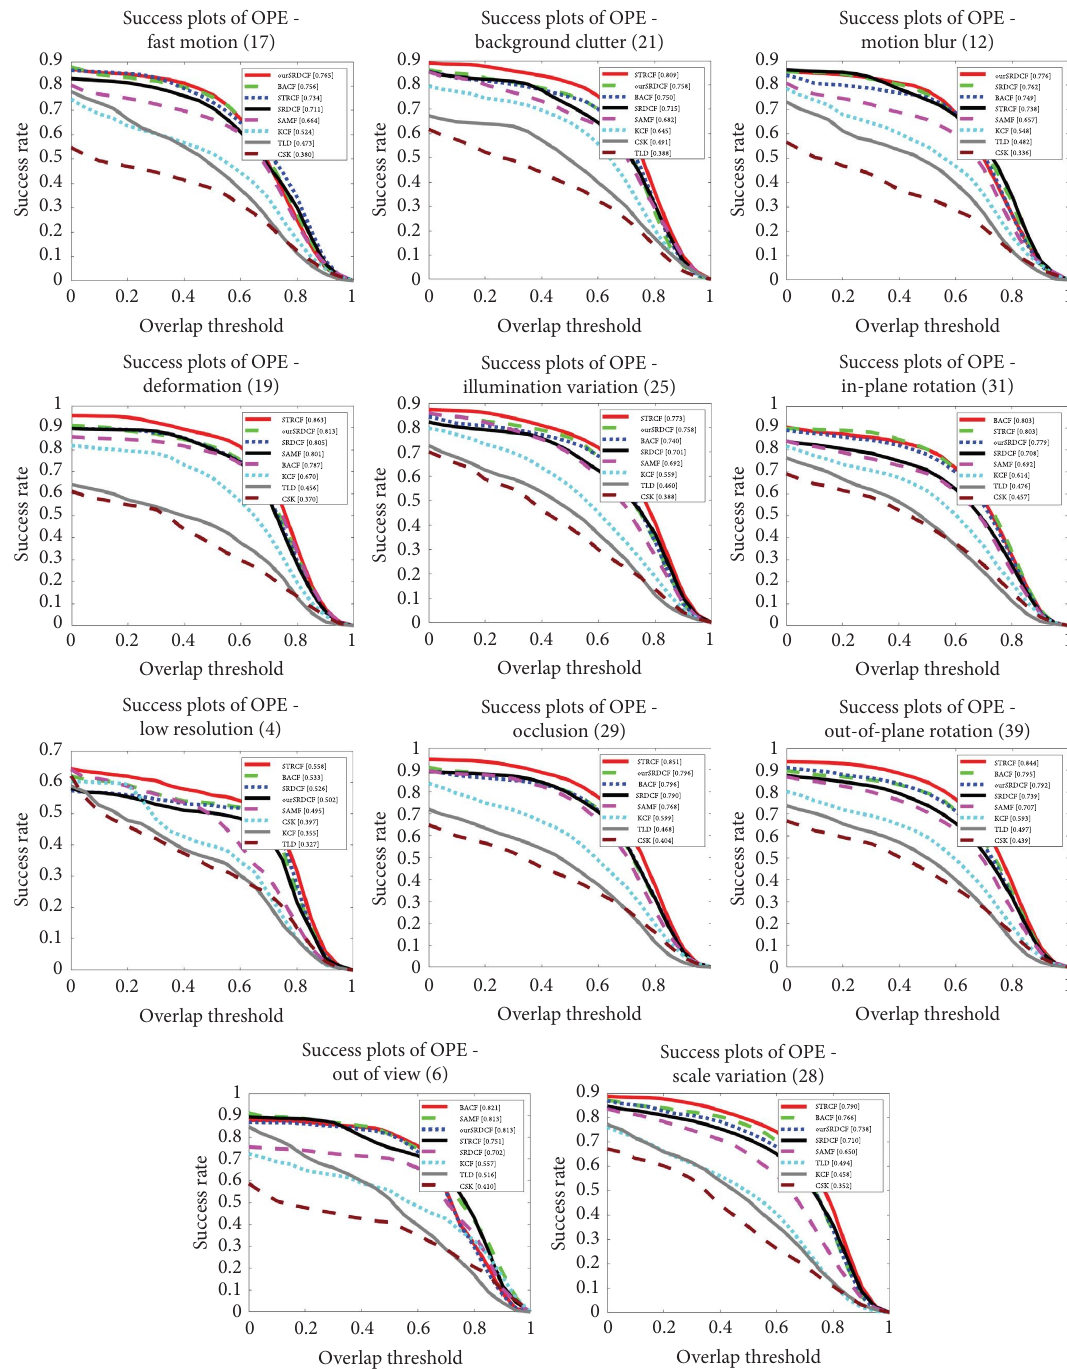
Figure 6: Te success rate curve of the six algorithms on the OTB-2015